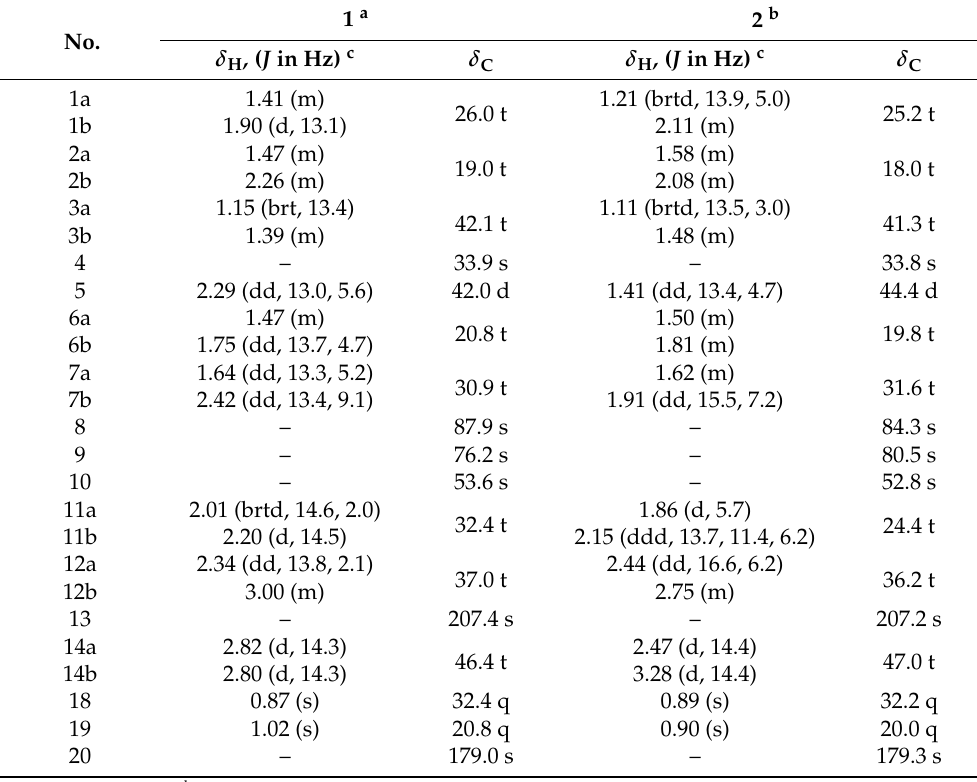
Table 1. 1 H and 13 C-NMR spectral data of 1 and 2 .